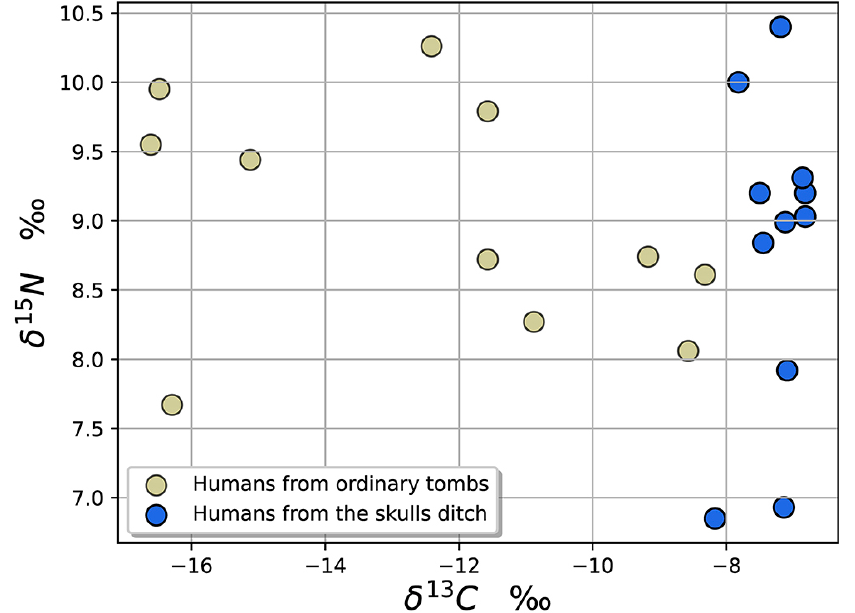
Figure 4. Human δ 13 C and δ 15 N values from Zhengzhou Shang City.